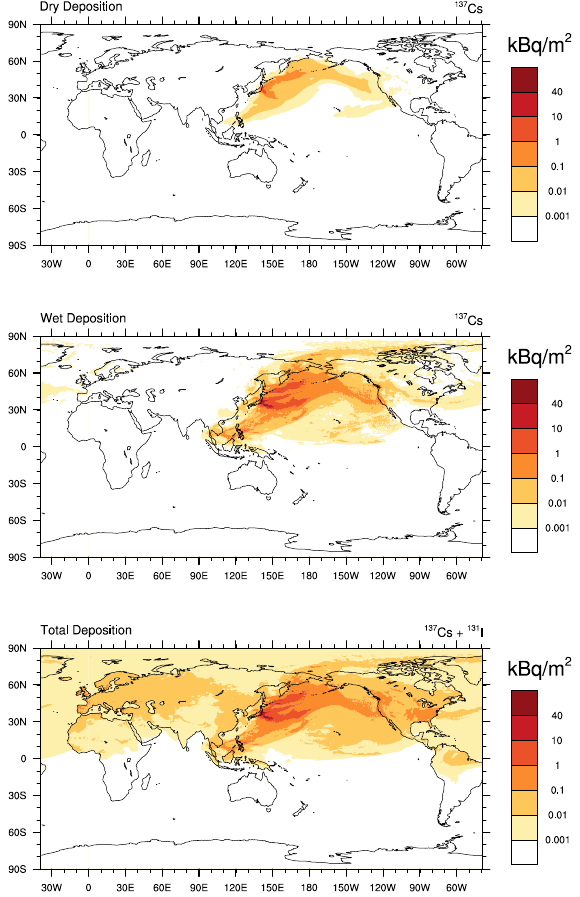
Fig. 6. Global distribution of dry (upper panel) and wet (middle panel) deposition (in Bq) of 137 Cs and total deposition (bottom panel) of 137 Cs and dry deposition of gaseous 131 I. Contours are on a logarithmic scale.